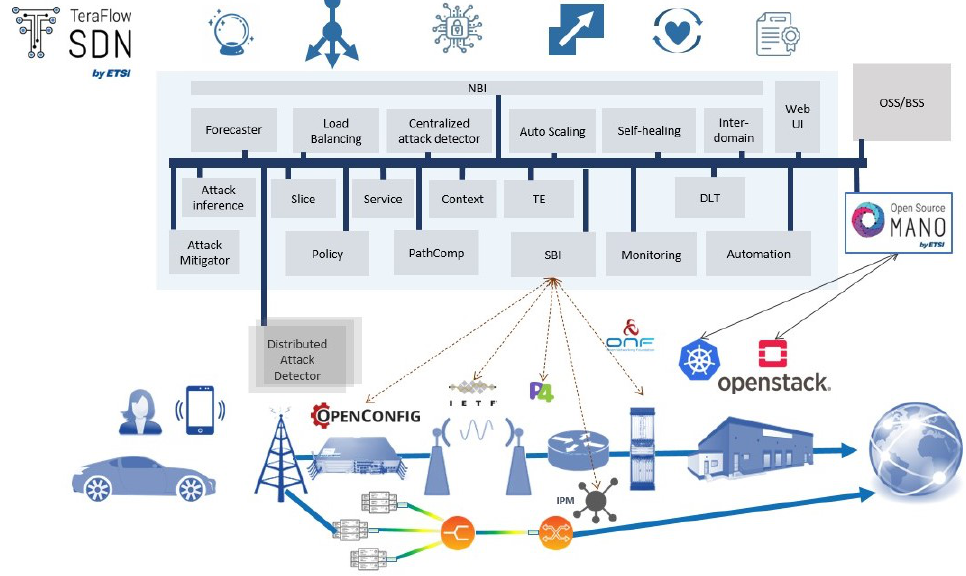
Figure 2. TeraFlowSDN architecture